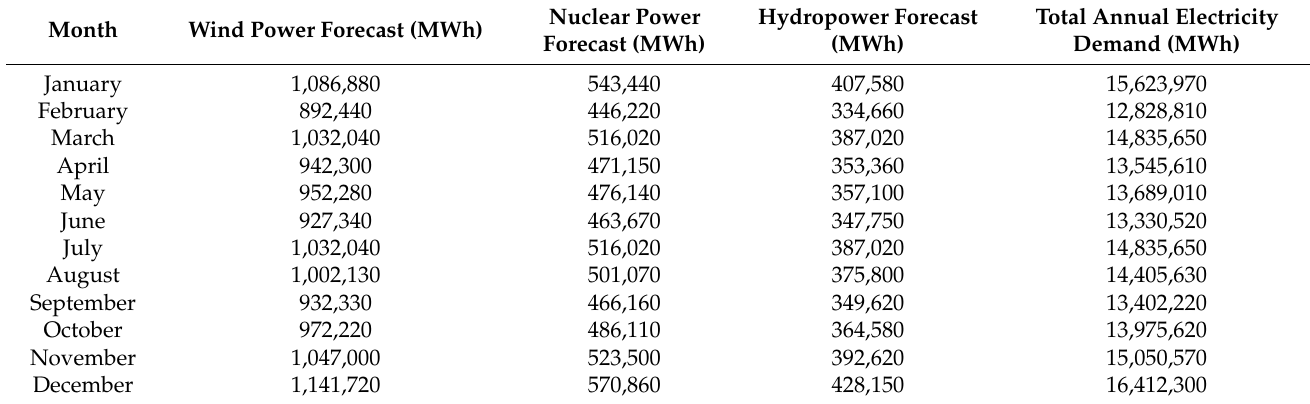
Table A4. Predicted electricity energy for the other type of units.